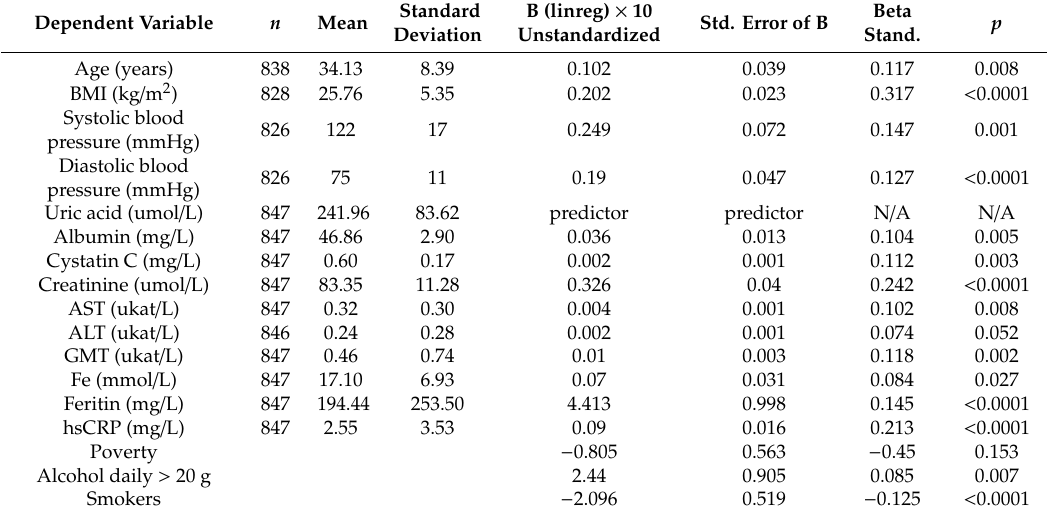
Table 2. Relationship between uric acid adjusted for age and sex and dependent variables in all study participants. Dependent